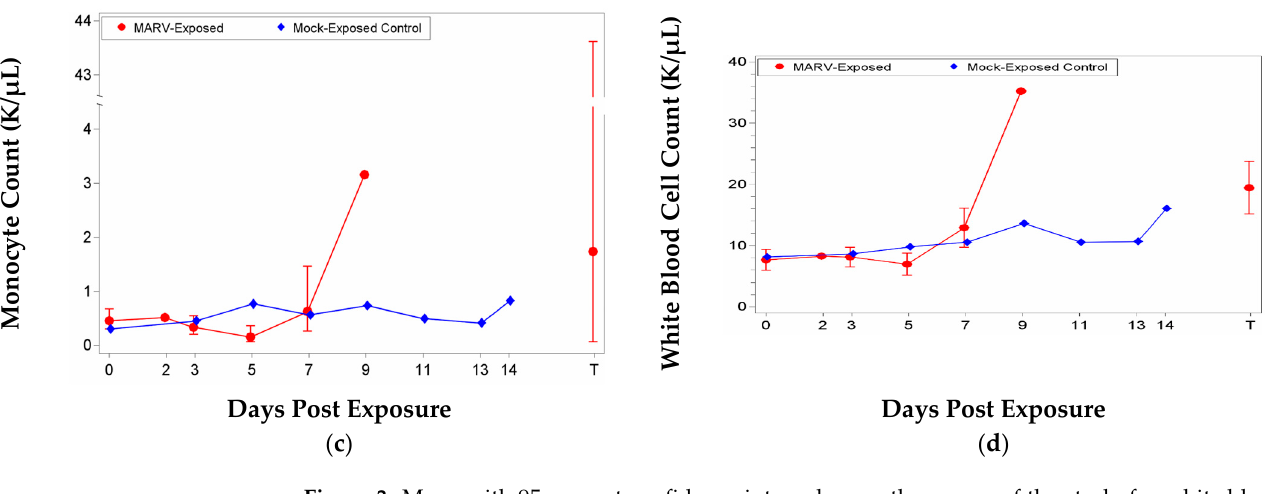
Figure 3. Mean with 95 percent confidence intervals over the course of the study for white blood cell parameters. Confidence interval was not plotted for sample size less than 3. Unless otherwise noted, values were log ‐ transformed, and the geometric mean is displayed. Terminal (T)—Terminal data collected from animals that met euthanasia criteria (unscheduled euthanasia) were combined and reported as a single time point. ( a ) Lymphocyte counts; ( b ) Granulocyte counts; ( c ) Monocyte counts; ( d ) White blood cell counts—values for this parameter were not log ‐ transformed; arithmetic mean displayed. For ( a – c ), the 95 percent confidence intervals are not symmetric because geometric confidence bounds are displayed on a linear scale.